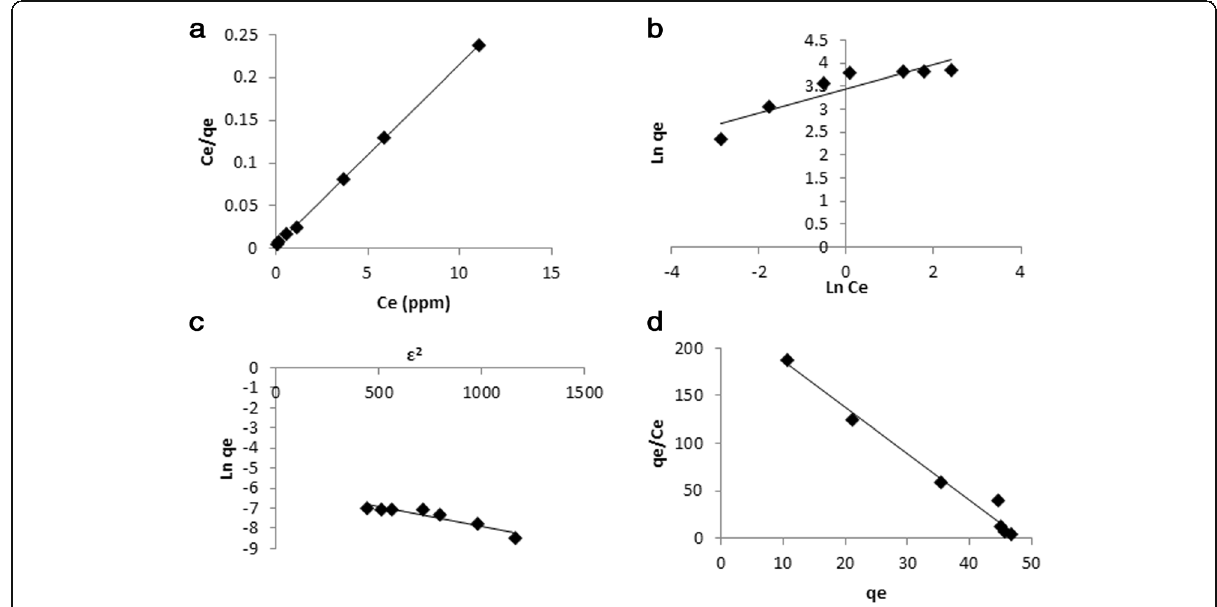
Fig. 10 Isotherms plot for the adsorption of Cr (VI) onto N6,6/GO. a Langmuir. b Freundlich. c Dubinin-Radushkevich. d